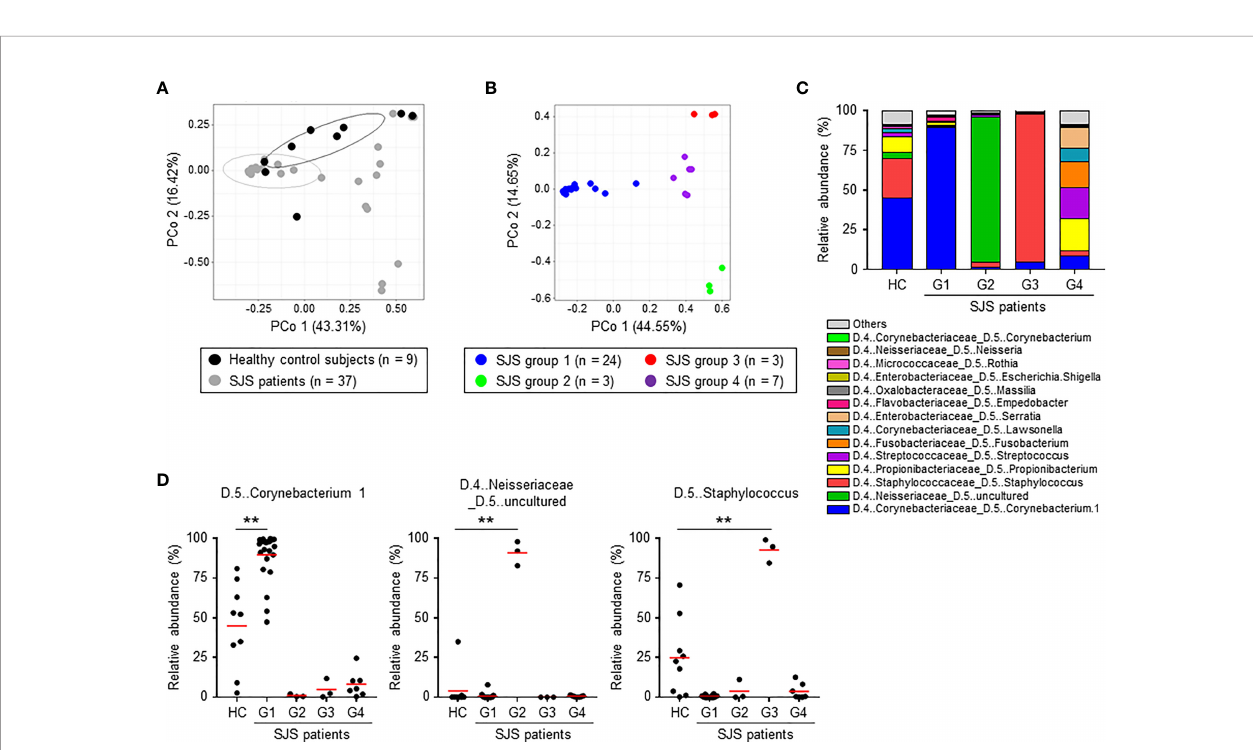
FIGURE 2 | Composition of the ocular microbiome in healthy control subjects and SJS/TEN patients with SOC. (A) Principal coordinate analysis (PCoA) based on Bray – Curtis distance at the genus level was conducted to compare the composition of the ocular microbiome between healthy control subjects and SJS patients. (B) Classi fi cation of SJS patients into four groups based on the composition of the ocular microbiome at the genus level by PCoA. (C) Relative abundances (%) of the genera comprising the ocular microbiome of HC subjects and SJS patients. (D) Relative abundances (%) of the genera Corynebacterium 1 , Neisseriaceae uncultured , and Staphylococcus in the ocular microbiome of HC subjects and SJS patients. Statistical signi fi cance was evaluated by one-way ANOVA; ** p < 0.01. HC, Healthy controls (n = 9); G1, SJS group 1 (n = 24); G2, SJS group 2 (n = 3); G3, SJS group 3 (n = 3); G4, SJS group 4 (n = 7). SJS, SJS/TEN patients with